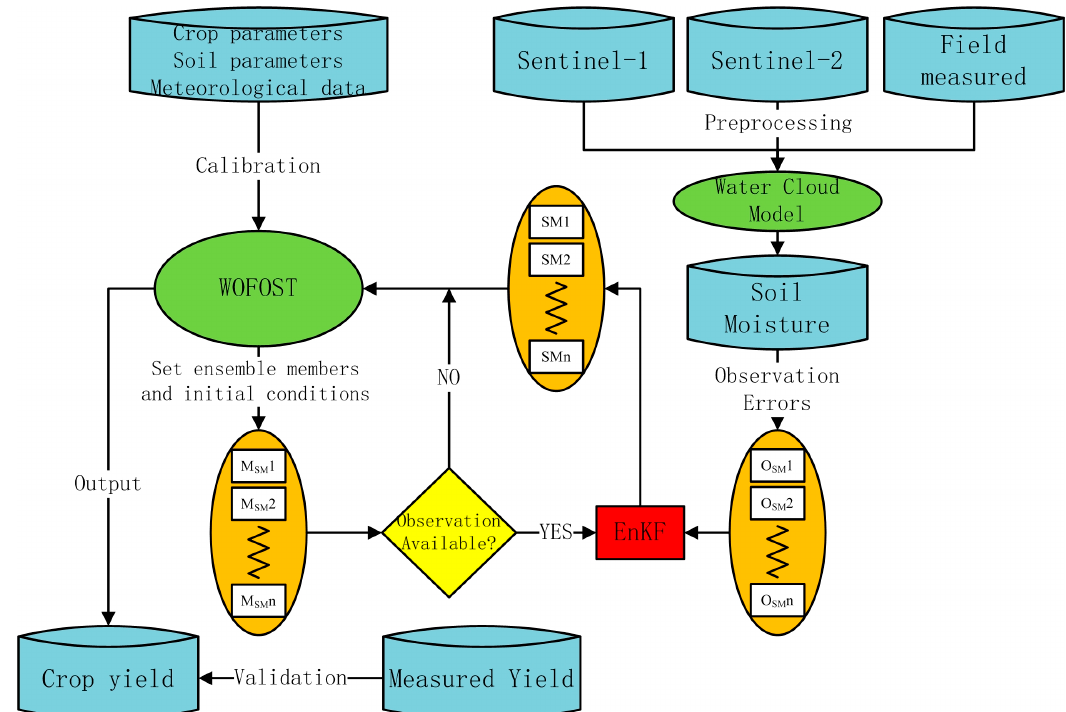
Figure 3. Flowchart for the winter wheat yield estimation using the EnKF-based assimilation algorithm.